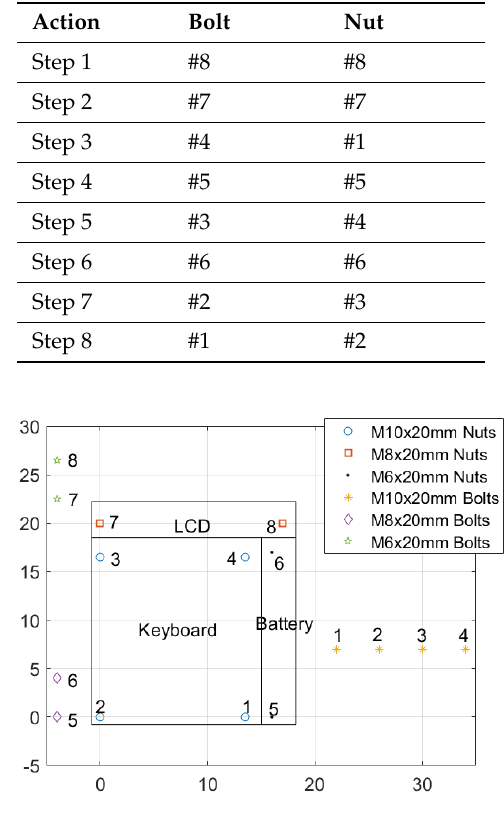
Figure 4. 2D position of nuts and bolts in assembly task.